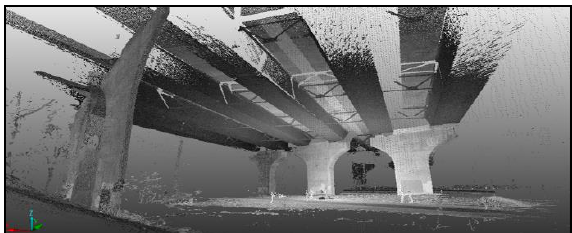
Figure 3. 3D reconstruction of LiDAR scanning data of a highway